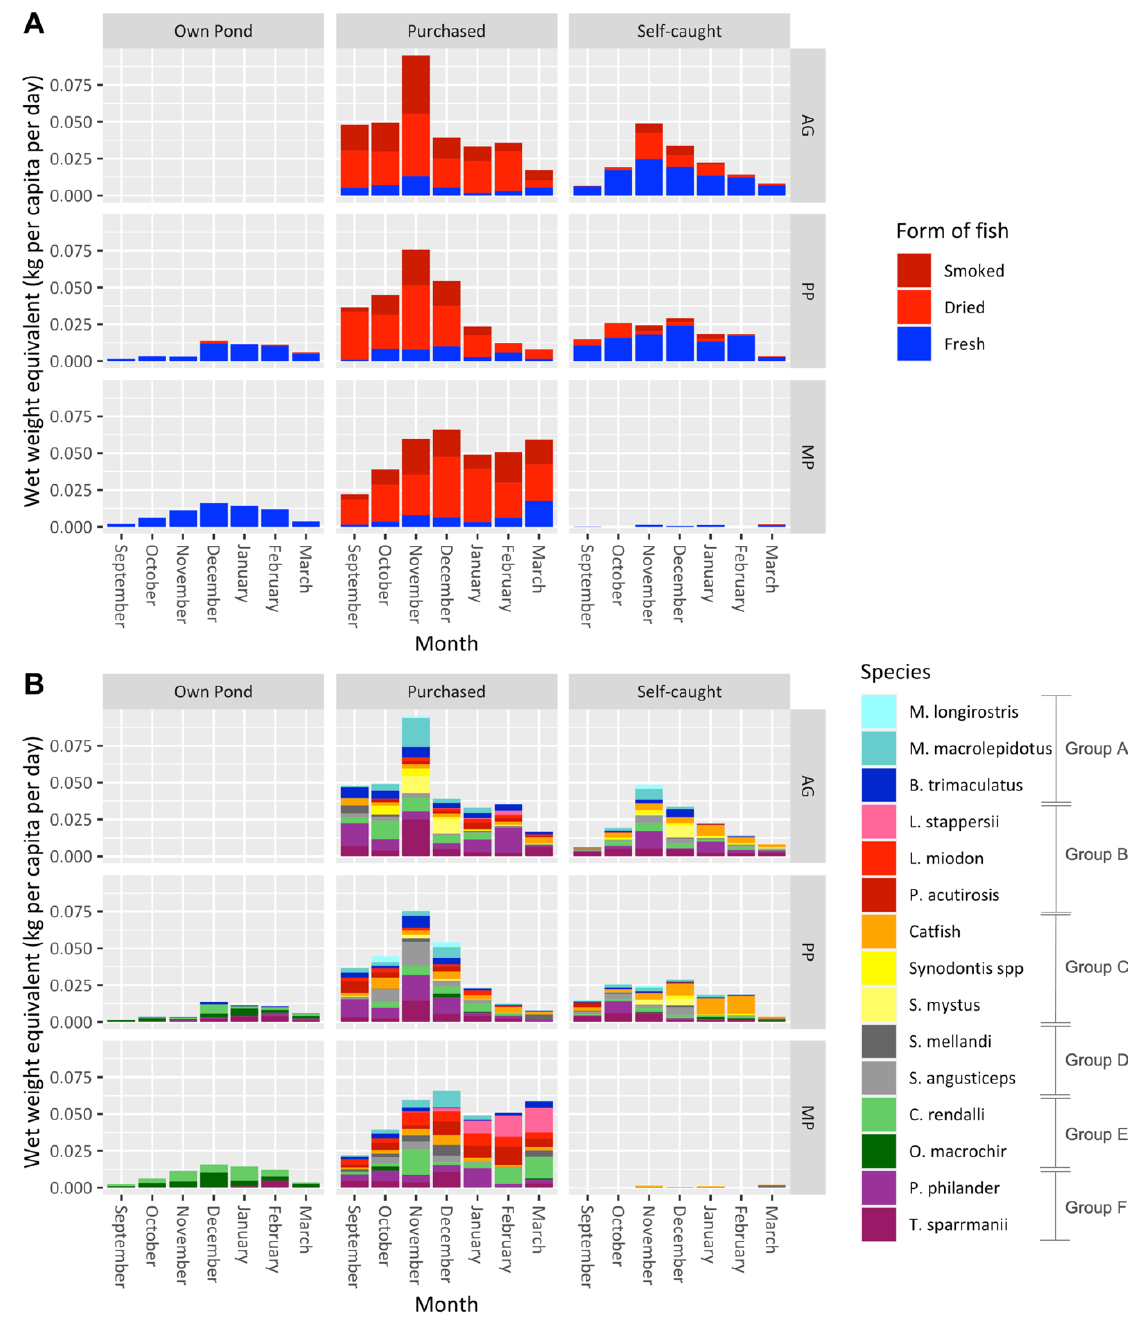
Figure 3. Monthly quantity of fish consumed as a wet weight equivalent (kg/capita/day) according to the three study groups and sources of fish: ( A ) form of preparation of fish; ( B ) species. Group A: mormyrids and local barbs, generally consumed as juveniles and caught in small lagoons and channels in wetlands. Group B: caught in the pelagic zones of large, further-away fisheries and frequently traded throughout Zambia. Group C: catfishes of all sizes and some of the most frequently consumed fish in the region. Group D: large, robust cichlids caught in nets or with hand-lines. Group E: widely consumed tilapias that are frequently cultured in ponds but are mainly sourced from capture fisheries. Group F: small, wild cichlids that are widely consumed and usually gain entry into farmers’